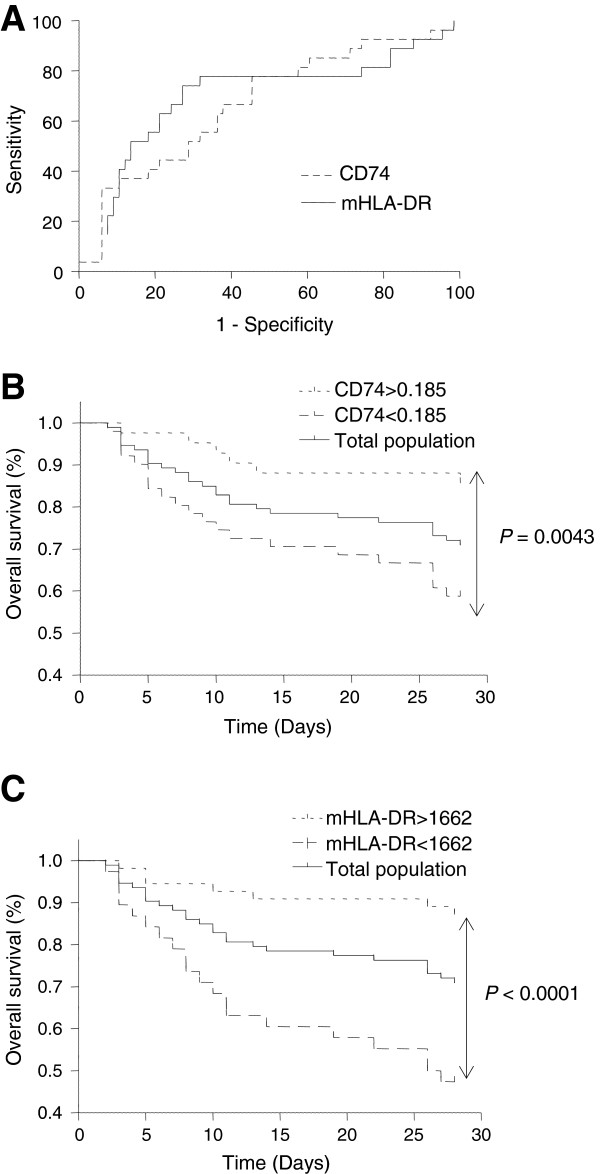
Prognostic value of mHLA-DR and CD74 mRNA levels in septic shock patients.CD74 mRNA level and circulating monocyte HLA-DR expression (mHLA-DR) were measured in blood samples obtained from 93 septic shock patients at Day 3 or Day 4 after the onset of shock. A). Receiver operating characteristic curves were established for these two parameters. The area under the curve was 0.67 for CD74 (95% confidence interval (95% CI): 0.55 to 0.79; P = 0.01) and 0.70 (95% CI: 0.57 to 0.83; P = 0.003) for mHLA-DR. B). Kaplan-Meier survival curves were established after stratification based on CD74 mRNA level cut-off value (= 0.185, optimized Youden index). A significant difference was measured between the two curves (Log rank test, P = 0.0043; Hazard Ratio = 3.0, 95% CI: 1.4 to 6.5). C). Similar analysis was performed for mHLA-DR. Cut-off value = 1,662 AB/C. Log rank test: P <0.0001, Hazard Ratio = 5.8, 95% CI = 2.6 to 12.9.